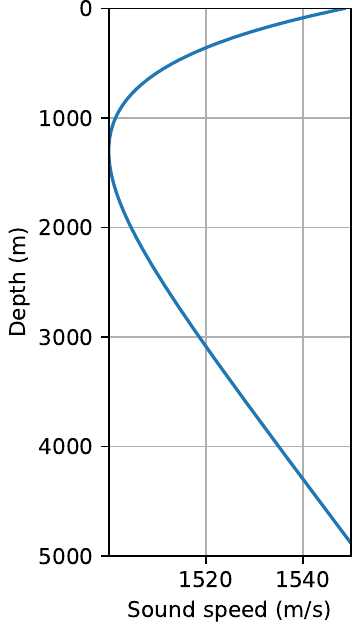
Figure 7. The Munk profile.